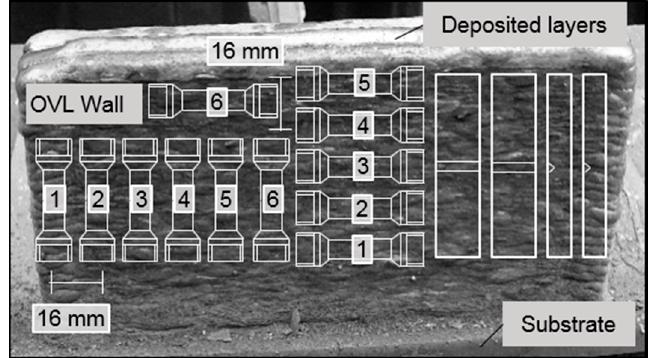
Figure 6. Arrangement of specimens for the mechanical properties analysis in both walls.